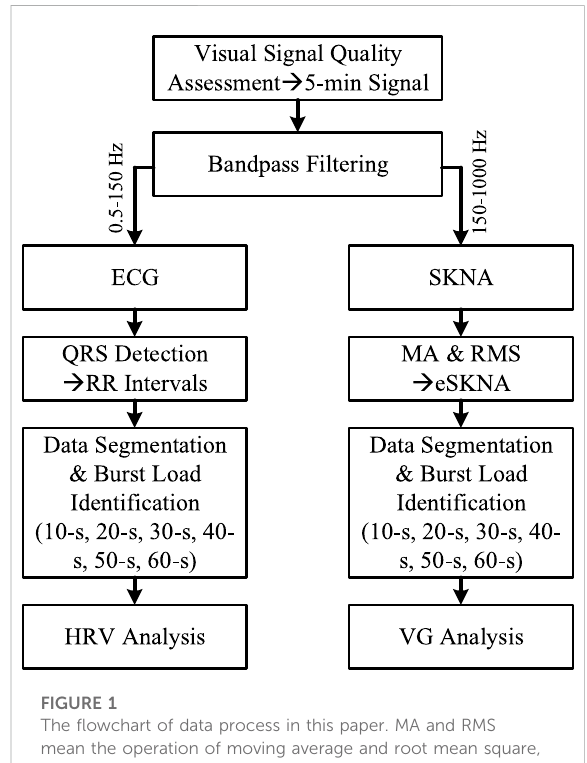
FIGURE 1 The fl owchart of data process in this paper. MA and RMS mean the operation of moving average and root mean square,